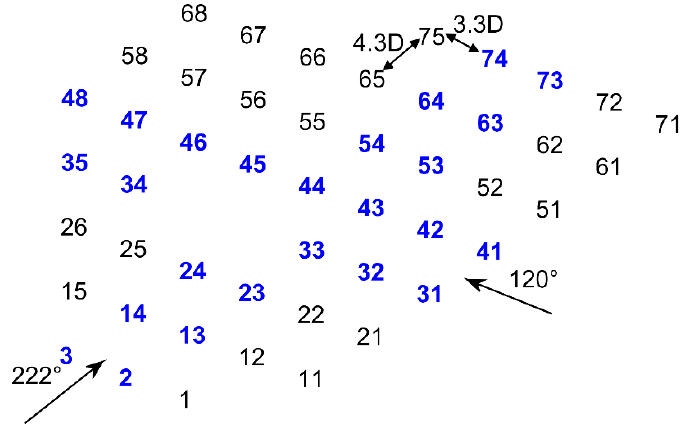
Figure 3. Layout of the Lillgrund offshore wind